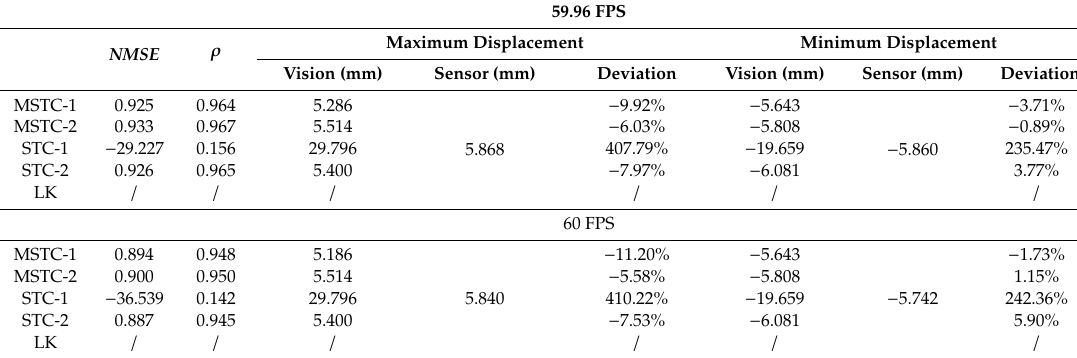
Table 6. Evaluation of displacement monitoring results with camera